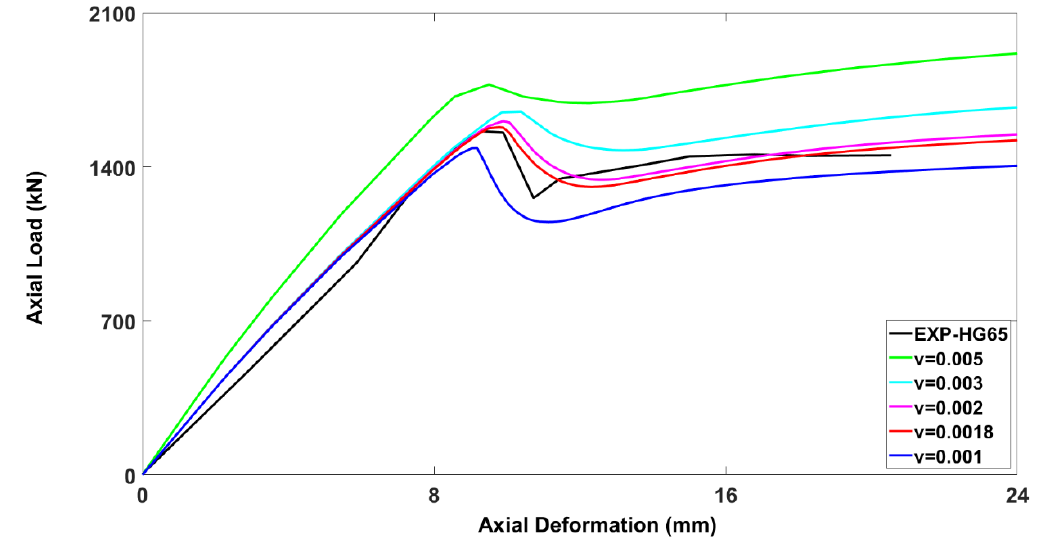
Figure 7. Calibration of control specimen (HG-65) for viscosity